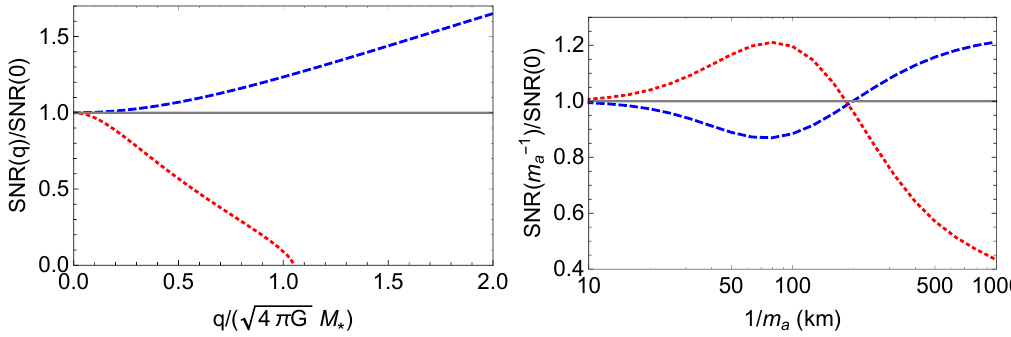
Figure 4 . (Left (cid:12)gure) The dependence of the total SNR on the charge q with a massless axion. The charge of the neutron stars is assumed to be the same while the masses are assumed to be 1 and 1.1 solar masses. The di(cid:11)erent masses are chosen to ensure that the scalar dipole moment does not vanish. The blue dotted curve is a new attractive force while the red dashed curve is a new repulsive force. We see that repulsive interactions make the neutron stars harder to detect while attractive interactions make them easier to detect. (Right (cid:12)gure) The dependence of the total SNR on mass of the axion. As before, we choose a 1 and 1.1 solar mass black hole with charges (cid:6) 1 so that the asymptotic result when m a ! 0 matches the (cid:12)gure on the left. As the range of the force approaches to the 100 km scale, the attractive (repulsive) interaction goes from being more (less) visible than normal neutron stars to being less (more)